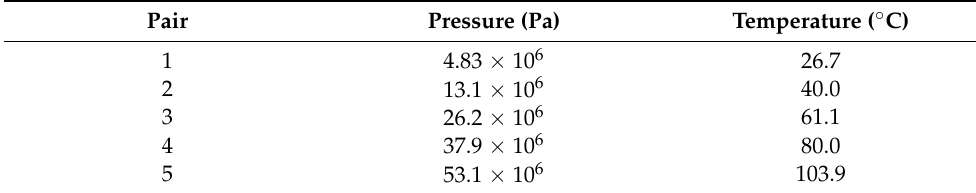
Table 2. The set-point of pressure and temperature for high pressure and high temperature (HPHT) rheology